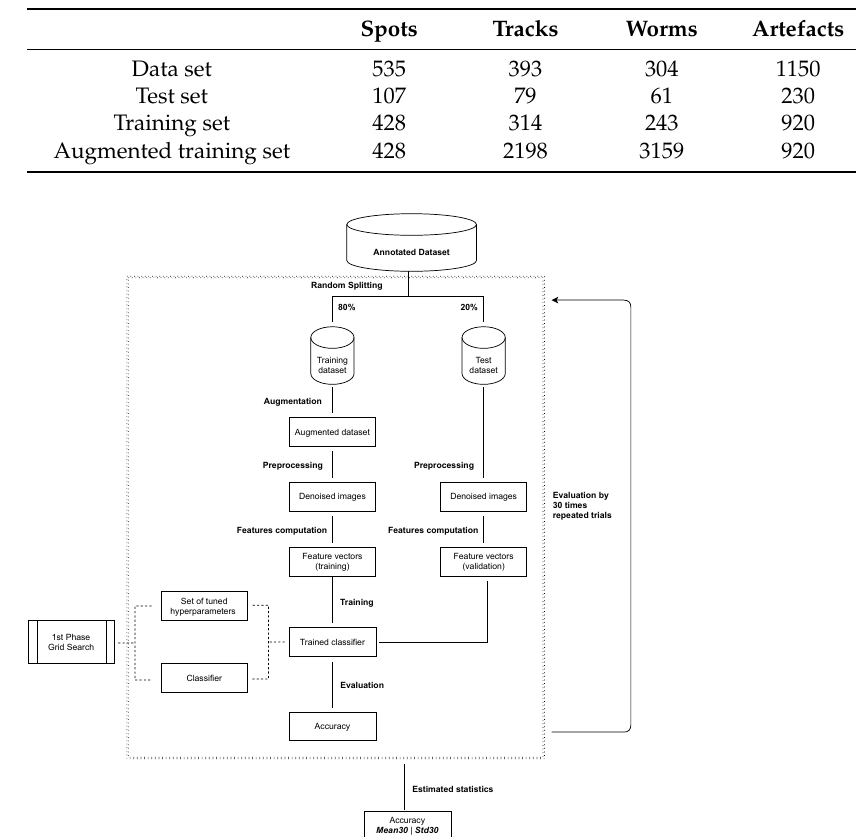
Figure 10. Descriptive scheme for the second phase of computation: model evaluation using 30 repeated classification